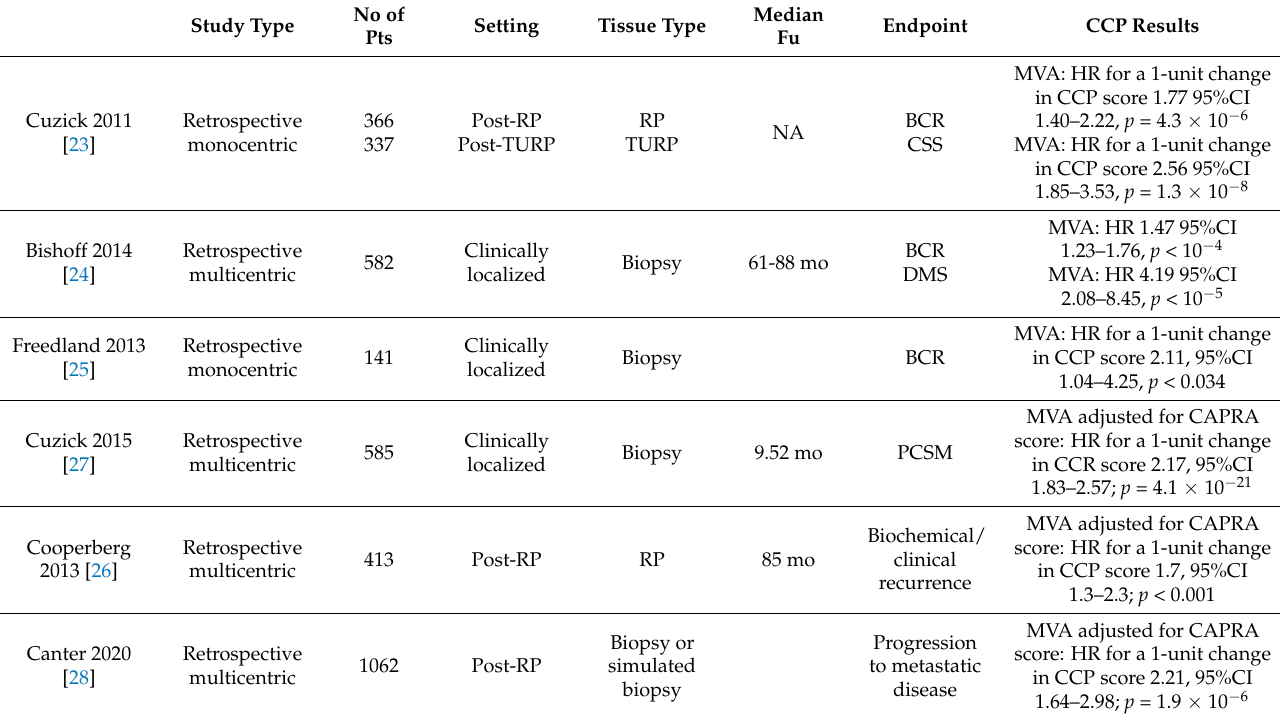
Table 3. Prolaris